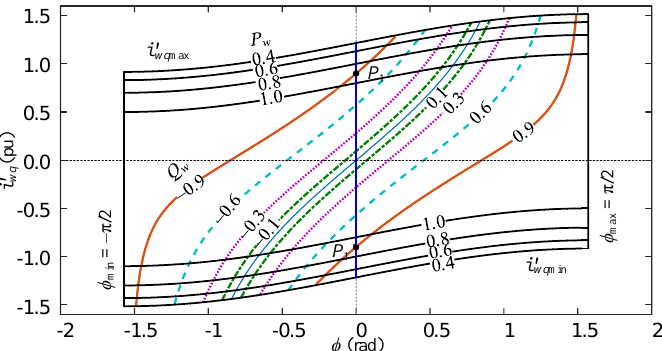
Figure 10. Different equilibrium curves and domains under different P w and Q w .